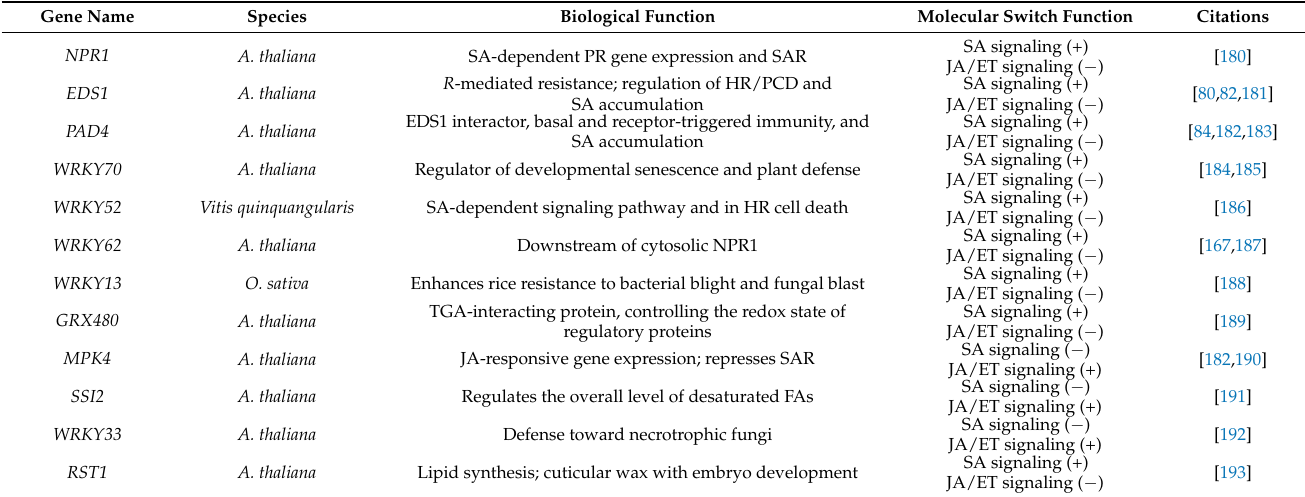
Table 1. Key regulators in SA and JA/ET